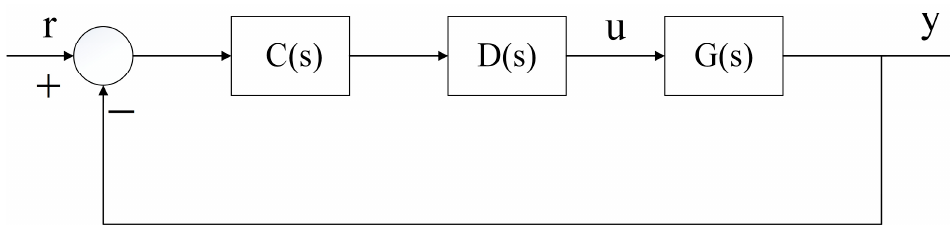
Figure 2. General structure of a decoupled system.